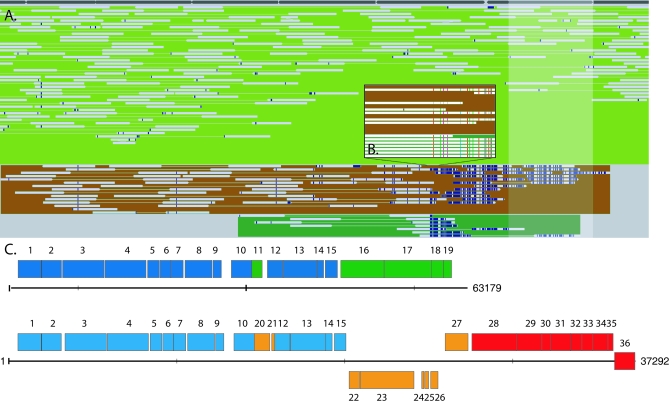
Extensive Strain Variation around the Origin of Replication Indicates Multiple Recombination Events(A) Strain variation captured within contig 11389. The white shading indicates the position of the ATPase involved in DNA replication. The composite sequence corresponds to the sequence of the olive-green strain type. Dark-blue regions on the reads indicate bases that disagree with the composite, either due to sequencing error (especially at read ends), insertions, or SNPs. Results illustrate the existence of three sequence types in this region (also see [B]). Although the brown and dark-green strain groups are highly divergent relative to the composite sequence over a region that begins shortly before the origin, it important to note that it is the dominant sequence type that becomes identical to the UBA Leptospirillum group II genome type due to a recombination event.(B) At higher magnification, it is evident that there were two 5-way CG strains in the population, only one of which was involved in the recombination event. The brown and dark-green strain sequence types terminate when they become too divergent to be coassembled into 11389. Most mate pairs missing from reads from the brown and dark dark-green strains at the base of the figure place at the start of scaffold 11386.(C) Diagram illustrating the two sequence variants present in the 5-way CG population, reconstructed at 11389 (top) and 11386 (bottom). Beyond this point, divergent small phage-like regions are followed by a 25-kb region in which all cells have the UBA Leptospirillum group II genome type. Note that the recombination block carries Cas proteins and the CRISPR locus (not shown in detail). Blue indicates genes shared between the two sequence variants, green indicates genes present only in the 11389 variant, orange indicates genes present only in the 11386 variant, and red indicates the cas proteins (100% identical between variants). Genes are annotated as follows: (1) chromosomal replication initiator protein (RepA); (2) DNA polymerase III, beta chain; (3) DNA gyrase, B subunit; (4) DNA gyrase, A subunit; (5) protein of unknown function; (6) putative radical activating enzyme; (7) ExsB protein; (8) leucyl aminopeptidase; (9) SsrA-binding protein; (10) putative integrase; (11–15) hypothetical protein; (16–17); putative Type III restriction/modification system, M and R subunits; (18–19) hypothetical protein; (20) hypothetical protein; (21) phage DNA binding protein; (22) conserved protein of unknown function; (23) DNA methyltransferase/helicase; (24–25) hypothetical protein; (26–27) probable transposase; (28) Cas3; (29) Cas1; (30) Cas2; (31) Cas4; (32) Cas5; (33) Cas3; (34) Cas1; (35) Cas2; and (36) CRISPR locus.